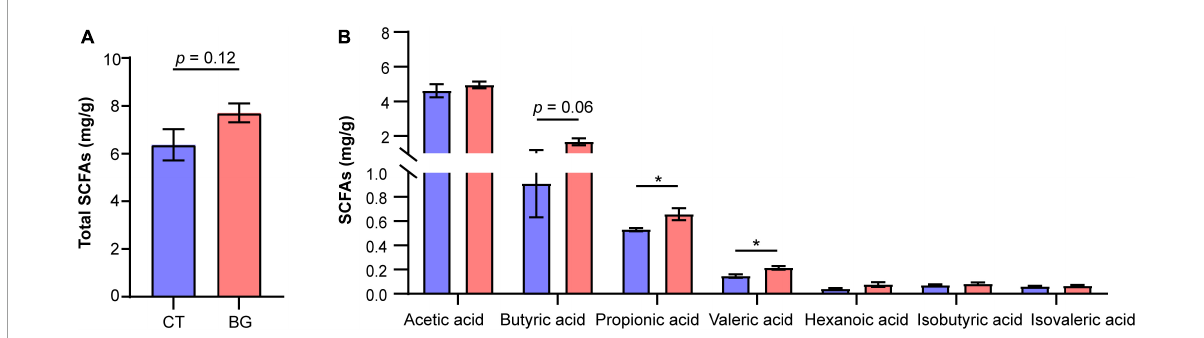
FIGURE4 (A) Total concentration of short-chain fatty acids (SCFAs). (B) The concentration of acetic, propionic, butyric, valeric, isovaleric, and isobutyric acids. * p < 0.05.